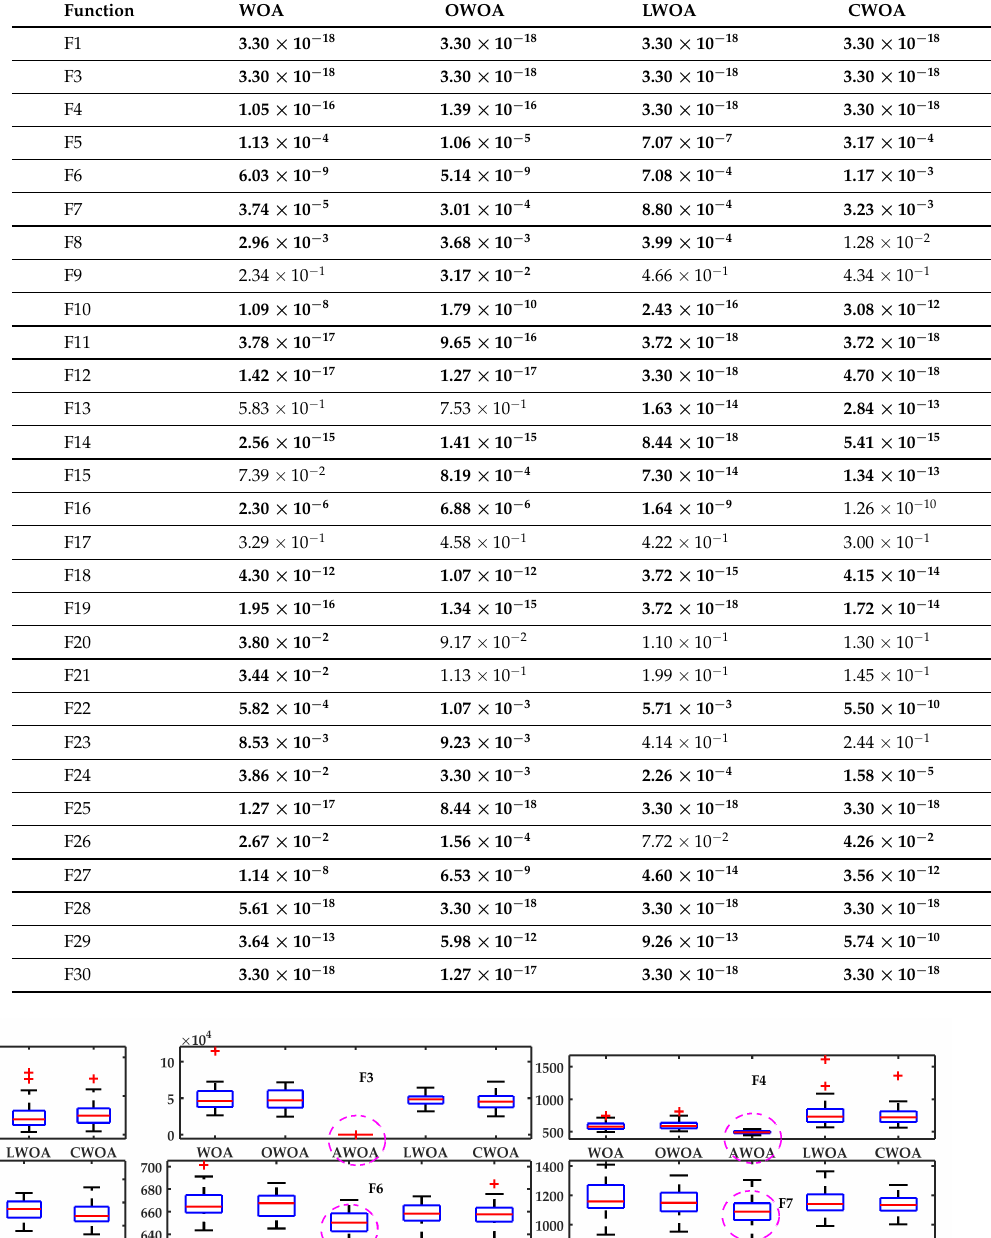
Table 8. Results of the rank sum test on Benchmark Suite-2 (30D).